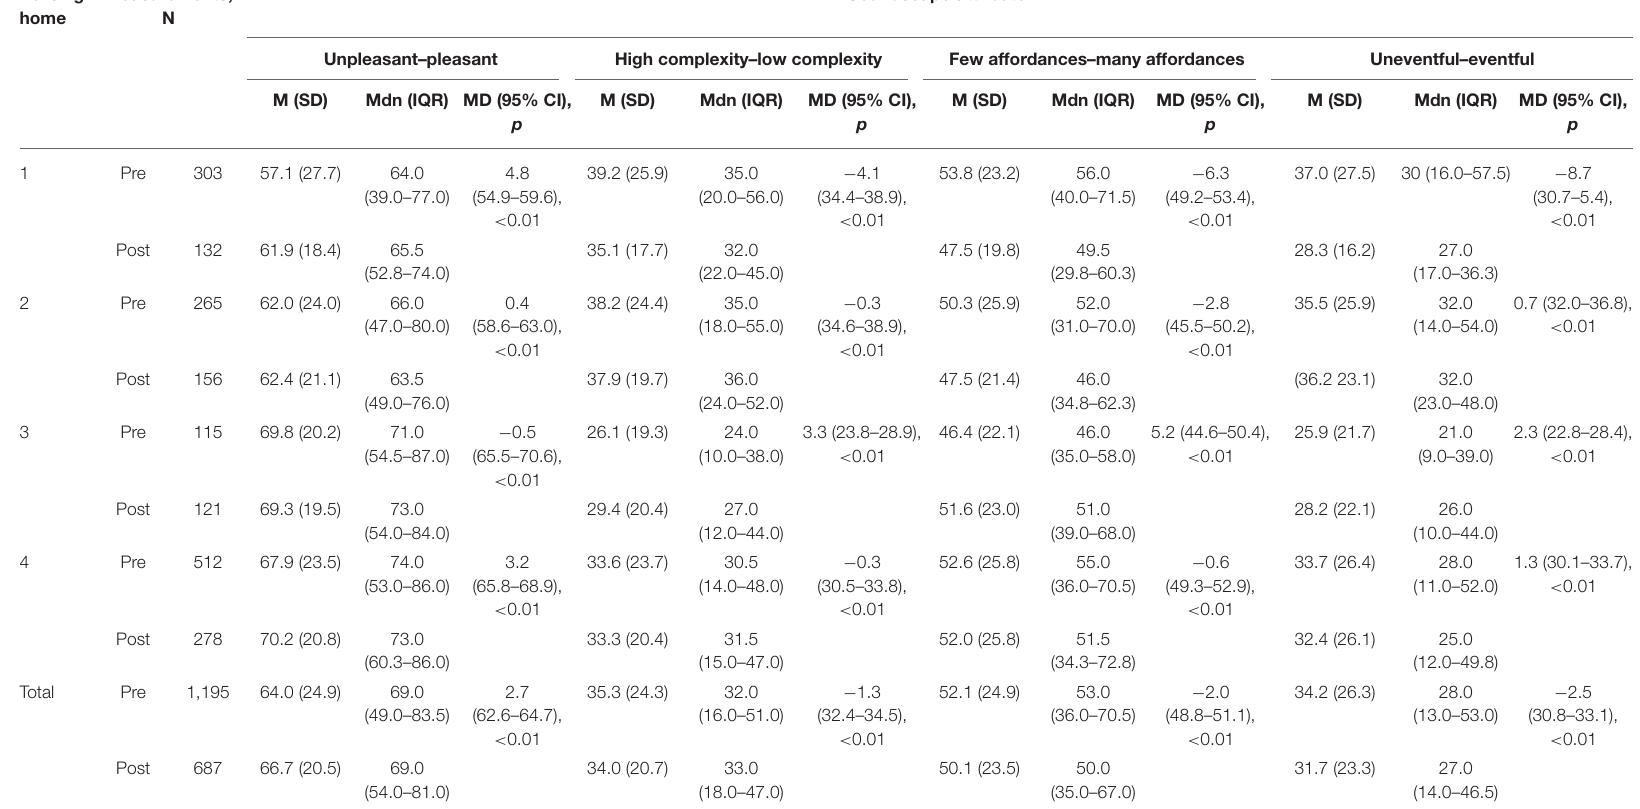
TABLE 1 | Soundscape attributes in participating nursing homes pre- and post-implementation of micro-interventions. Nursing